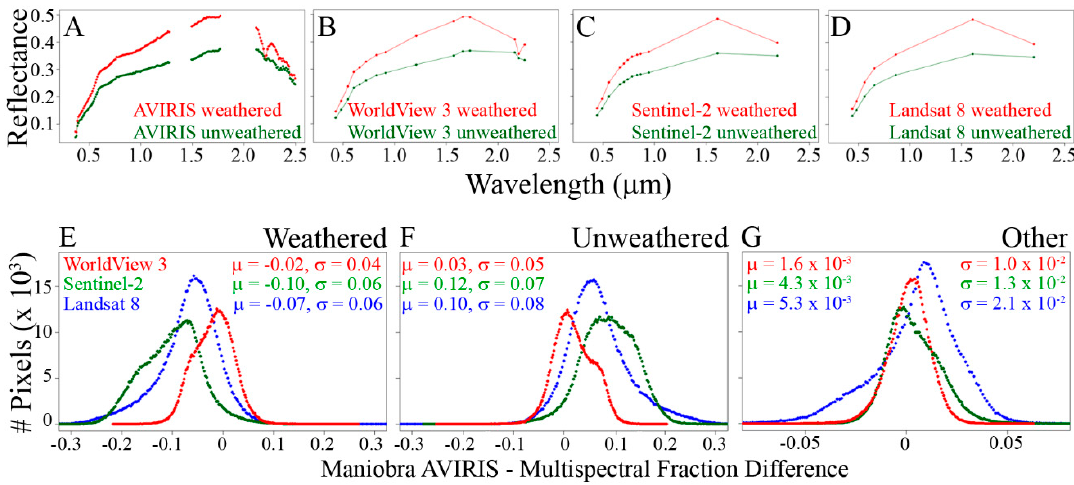
Figure 4. Maniobra spectral endmembers and fraction differences. Hyperspectral AVIRIS data (A) are resampled to WorldView 3 (B), Sentinel-2 (C), and Landsat 8 (D) spectral resolutions. Resampled AVIRIS image data is then unmixed with each set of resampled endmembers and differences images are computed for each fraction (E – G). WorldView 3 fraction estimates differ less from AVIRIS fractions than Sentinel-2 or Landsat 8 because of the additional SWIR bands.